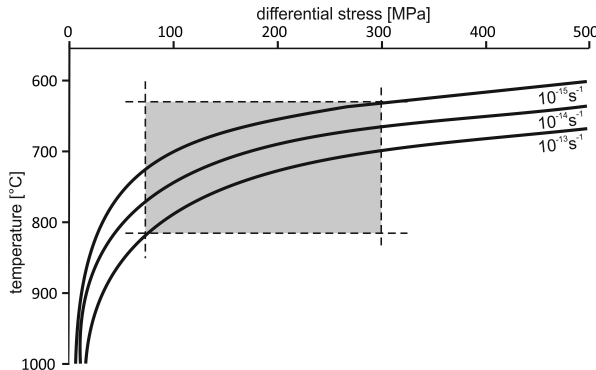
Fig. 9. Flow law for dislocation creep of olivine after Chopra and Paterson (1981). The box correlates inferred differential stresses of 70 to 300MPa to a temperature range of ca. 650 to 800 ◦ C at as- sumed reasonable strain rates of 10 − 13 to 10 − 15 s − 1